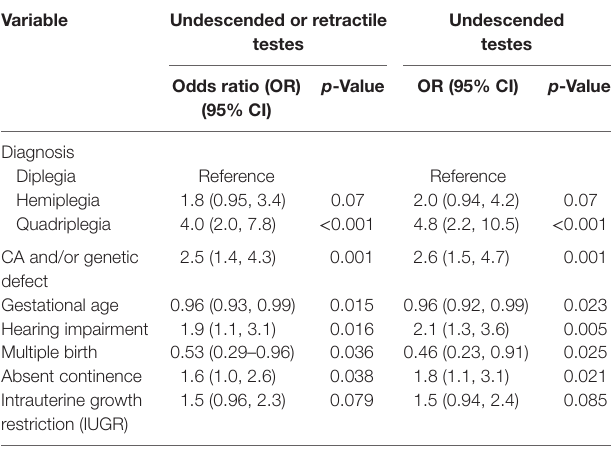
Variables included in the model: race, diagnosis, movement disorder, death, birth weight, gestational age, multiple birth, intrauterine growth restriction (IUGR), congenital anomaly (CA; non-CNS in addition to cryptorchidism) and/or genetic defect, postnatal injury, hydrocephalus, gastrostomy, absent continence, seizures, hearing impairment, visual impairment, abnormal speech, and intellectual